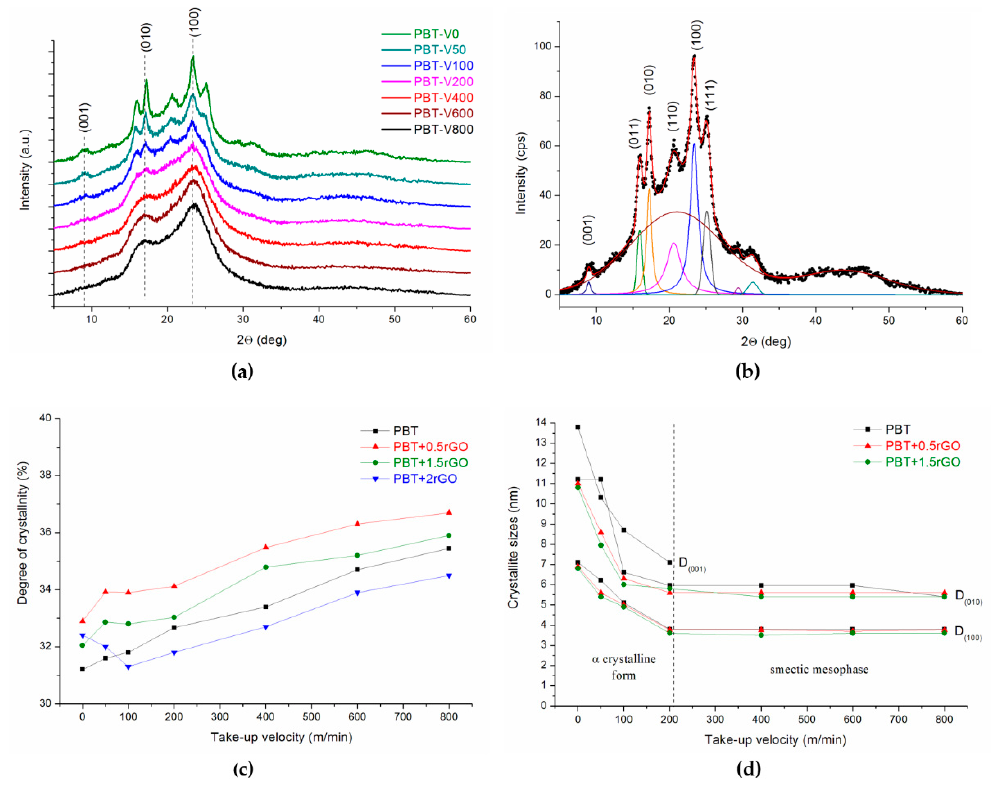
Figure 3. ( a ) Wide-angle X-ray scattering (WAXS) patterns of pure PBT fibers spun at di ff erent take-up velocities (the curves were shifted along the intensity axis for clarity); ( b ) deconvolution of the WAXS pattern of the PBT-V0 sample; ( c ) changes in crystallinity; ( d ) crystallite sizes of PBT fibers.